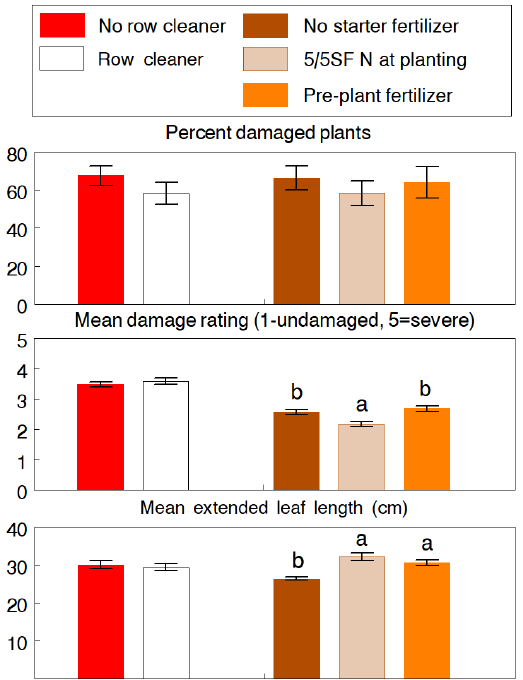
Figure 2. CREC experiment (1993). Effects of using row cleaner and different starter fertilizer practices at planting on damage caused of the gray garden slug, Deroceras reticulatum , and on the seedling growth and plant population in no-tillage corn. The 5/5SF treatment was 30 kg N/ha of 34-0-0 applied as a deep-band 5 cm to the side and 5 cm below the seed. The pre-plant treatment was a broadcast application of 10-10-10 at 500 kg/ha applied prior to planting. Pairs of means ( ± SEM) of each main effect with different letters are significantly different at the 5% probability level.